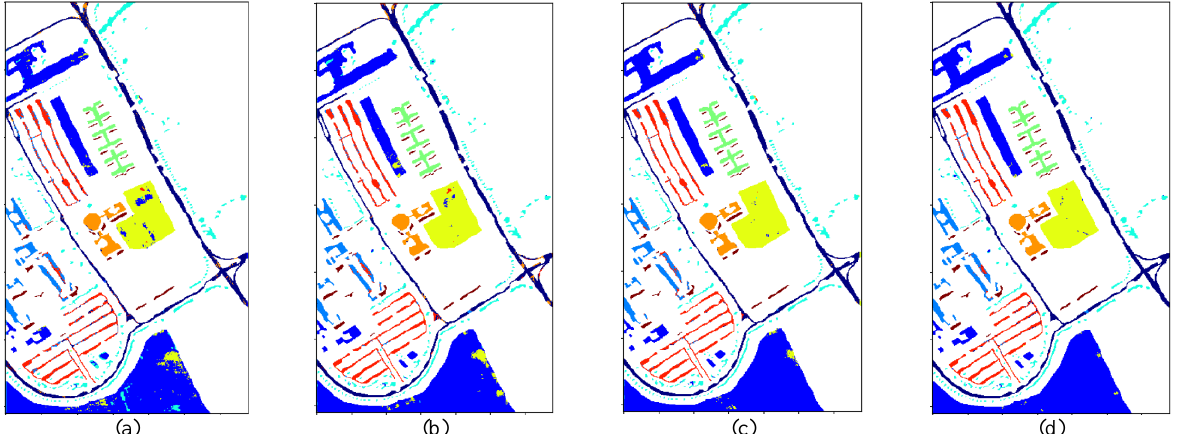
Figure 7. Classification results of Pavia with 7×7 input patch with 2 convolutional layers and 2 fully-connected layers trained with